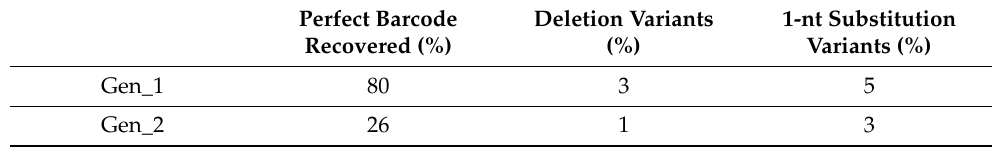
Table 3. Barcode recovery by library for 1 M read subsets.